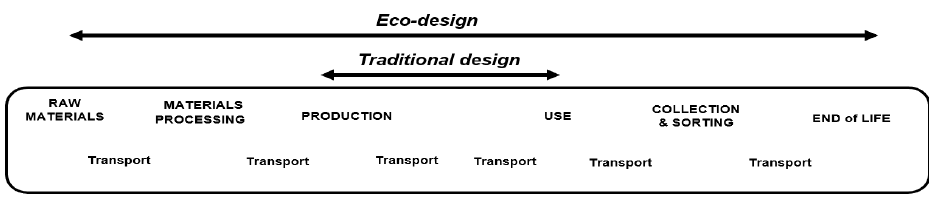
Fig. 4. Adapted from: Eco-design versus traditional design, Source: [50], p.